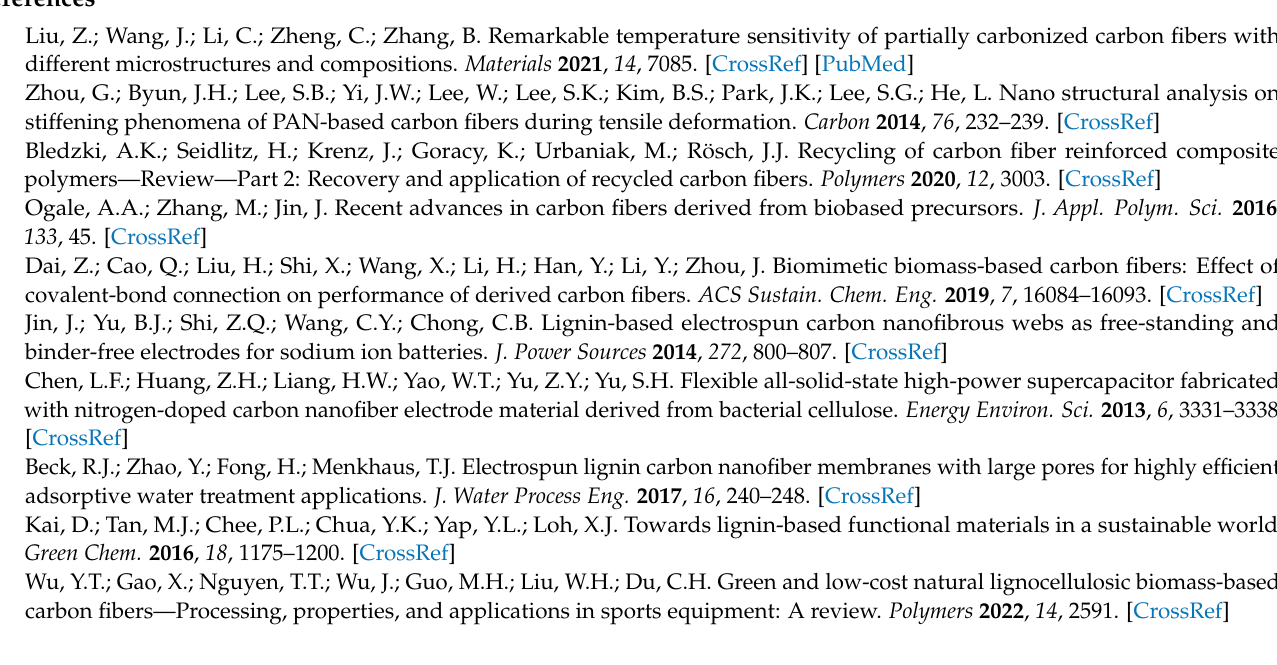
Figure S2. Element analysis of lignocellulose-based PFs. Table S1. Amounts of linking modes and monomer for poplar lignin and S/G ratio. Table S2. Elemental compositions of the samples. Table S3. BET results of CFs. Table S4. Fitting values for the parameters of the Nyquist plots. Table S5. Production of CFs from some lignocellulose-based blends and their advantages of characteristic. References [57–60] are cited in the supplementary